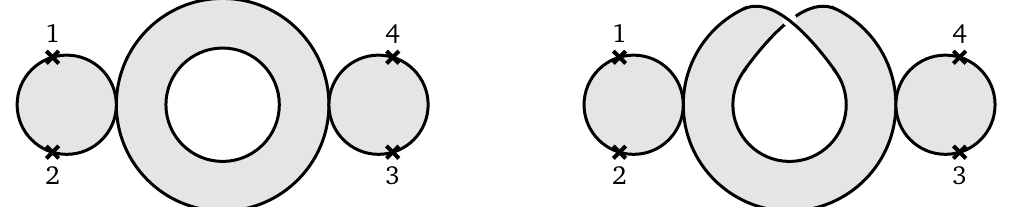
Figure 13: The double degeneration of the planar annulus and Möbius strip leading to the double pole in the amplitude at s ∈ (cid:90) ⩾